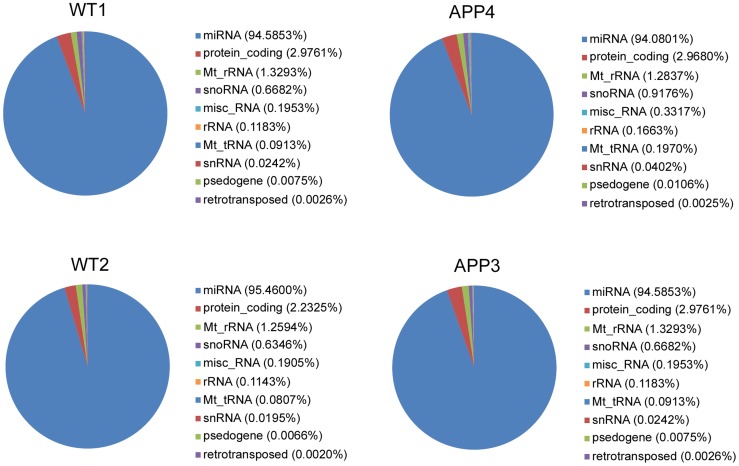
Annotation and distribution of small RNAs among different categories.snoRNA, small nucleolar RNA; mt, mitochondrial; rRNA, ribosobal RNA; tRNA, transfer RNA; snRNA, small nuclear RNA.